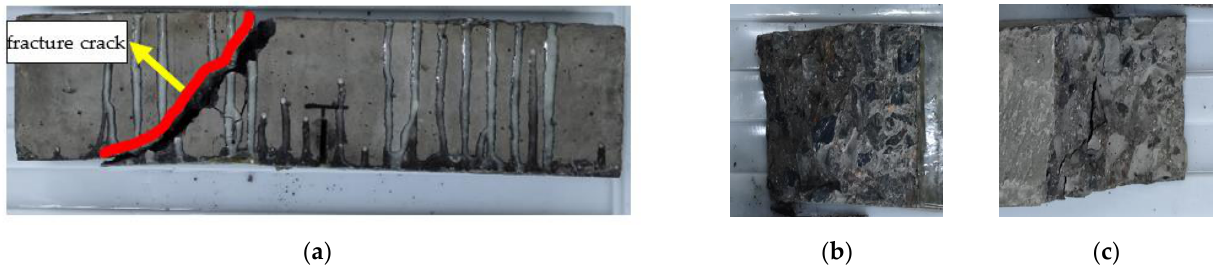
Figure 24. Failure mode of RFND: ( a ) side surface; ( b ) fracture surface 1; and ( c ) fracture surface 2.